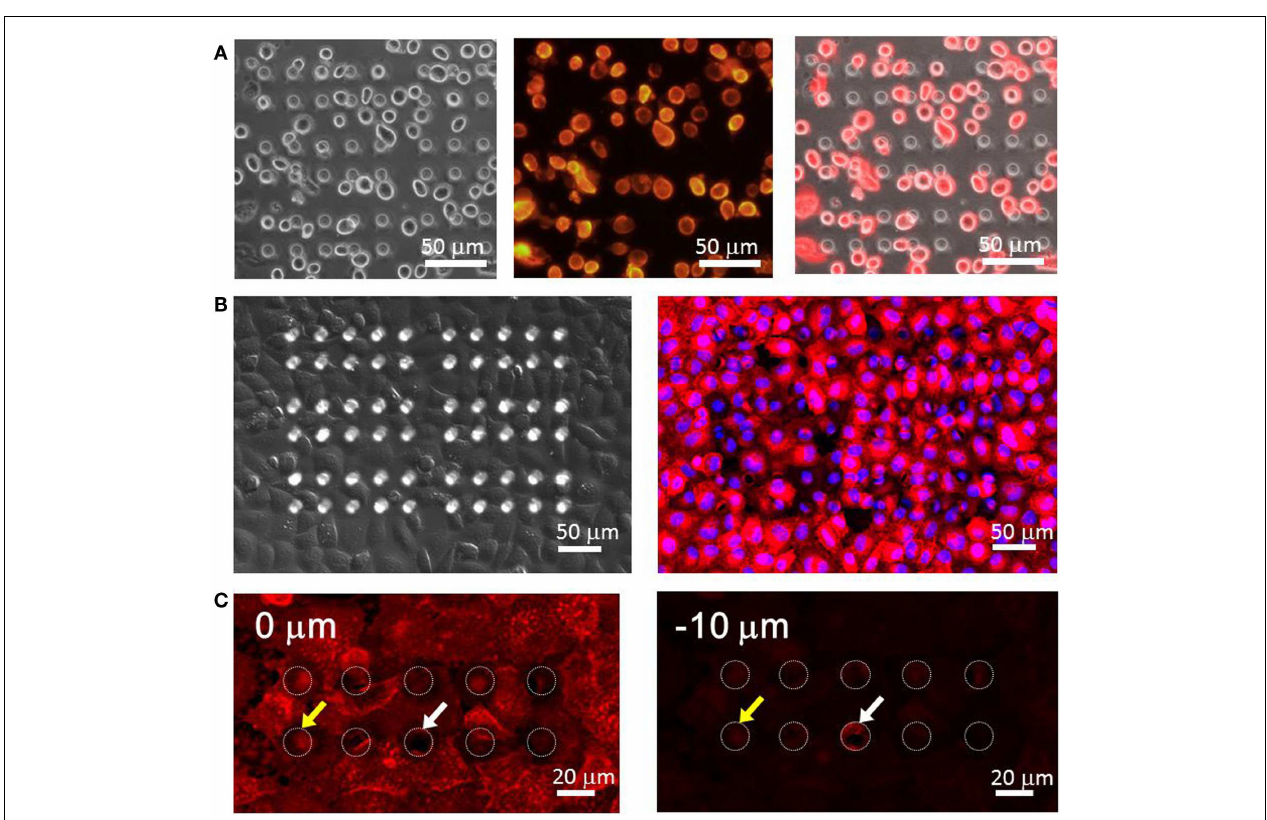
image.The red color shows the plasma membrane stained by DiI and the blue color shows the nucleus stained by Hoechst33342. (C) Imaging of the plasma membrane obtained at the surface of the chamber device (0 µ m, left) and at the middle of the chamber ( − 10 µ m,